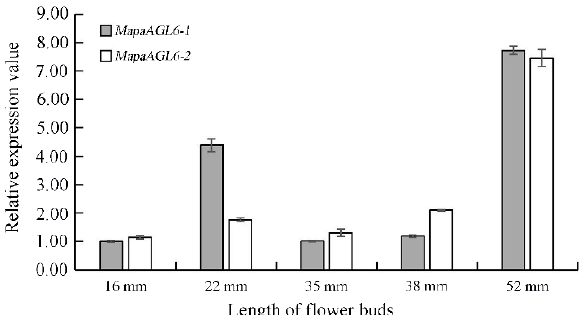
Figure 5. Relative expression of MapaAGL6-1 and MapaAGL6-2 in floral buds of different lengths.